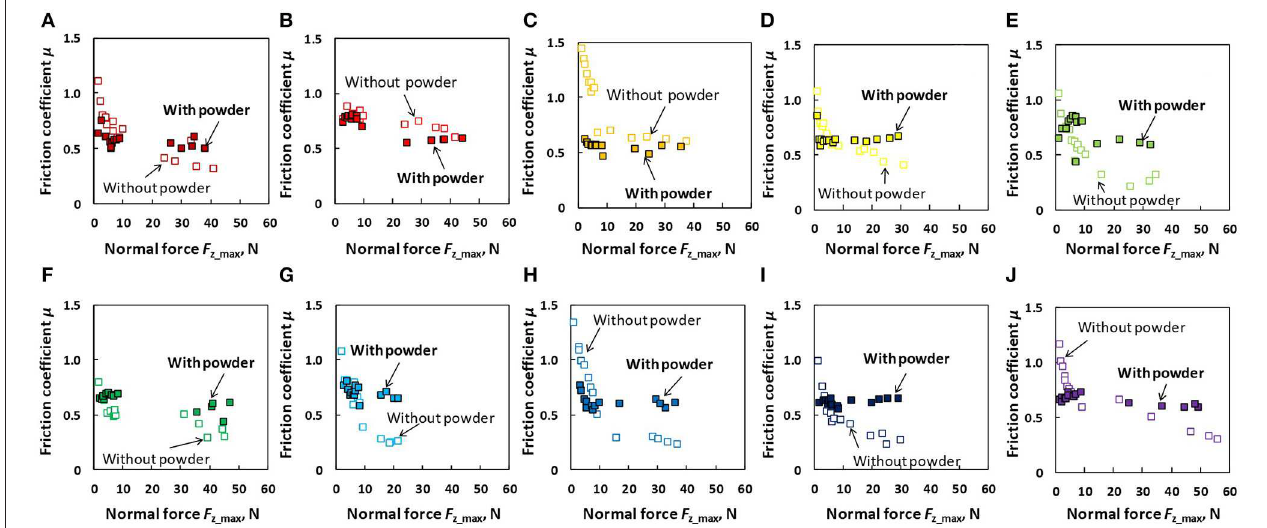
FIGURE 10 | Comparison of friction coefficient ( µ ) as a function of normal force ( F z_max ) between the wet non-powdered and powdered conditions for each participant. (A) Participant A, (B) participant B, (C) participant C, (D) participant D, (E) participant E, (F) participant F, (G) participant G, (H) participant H, (I) participant I, and (J) participant